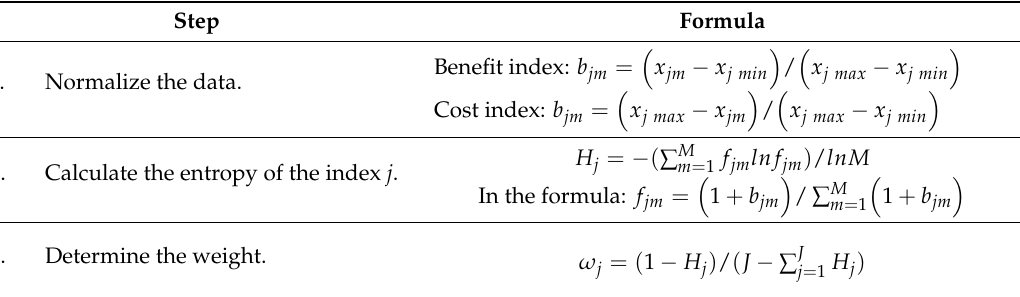
Table A2. The steps and formulas of EW.